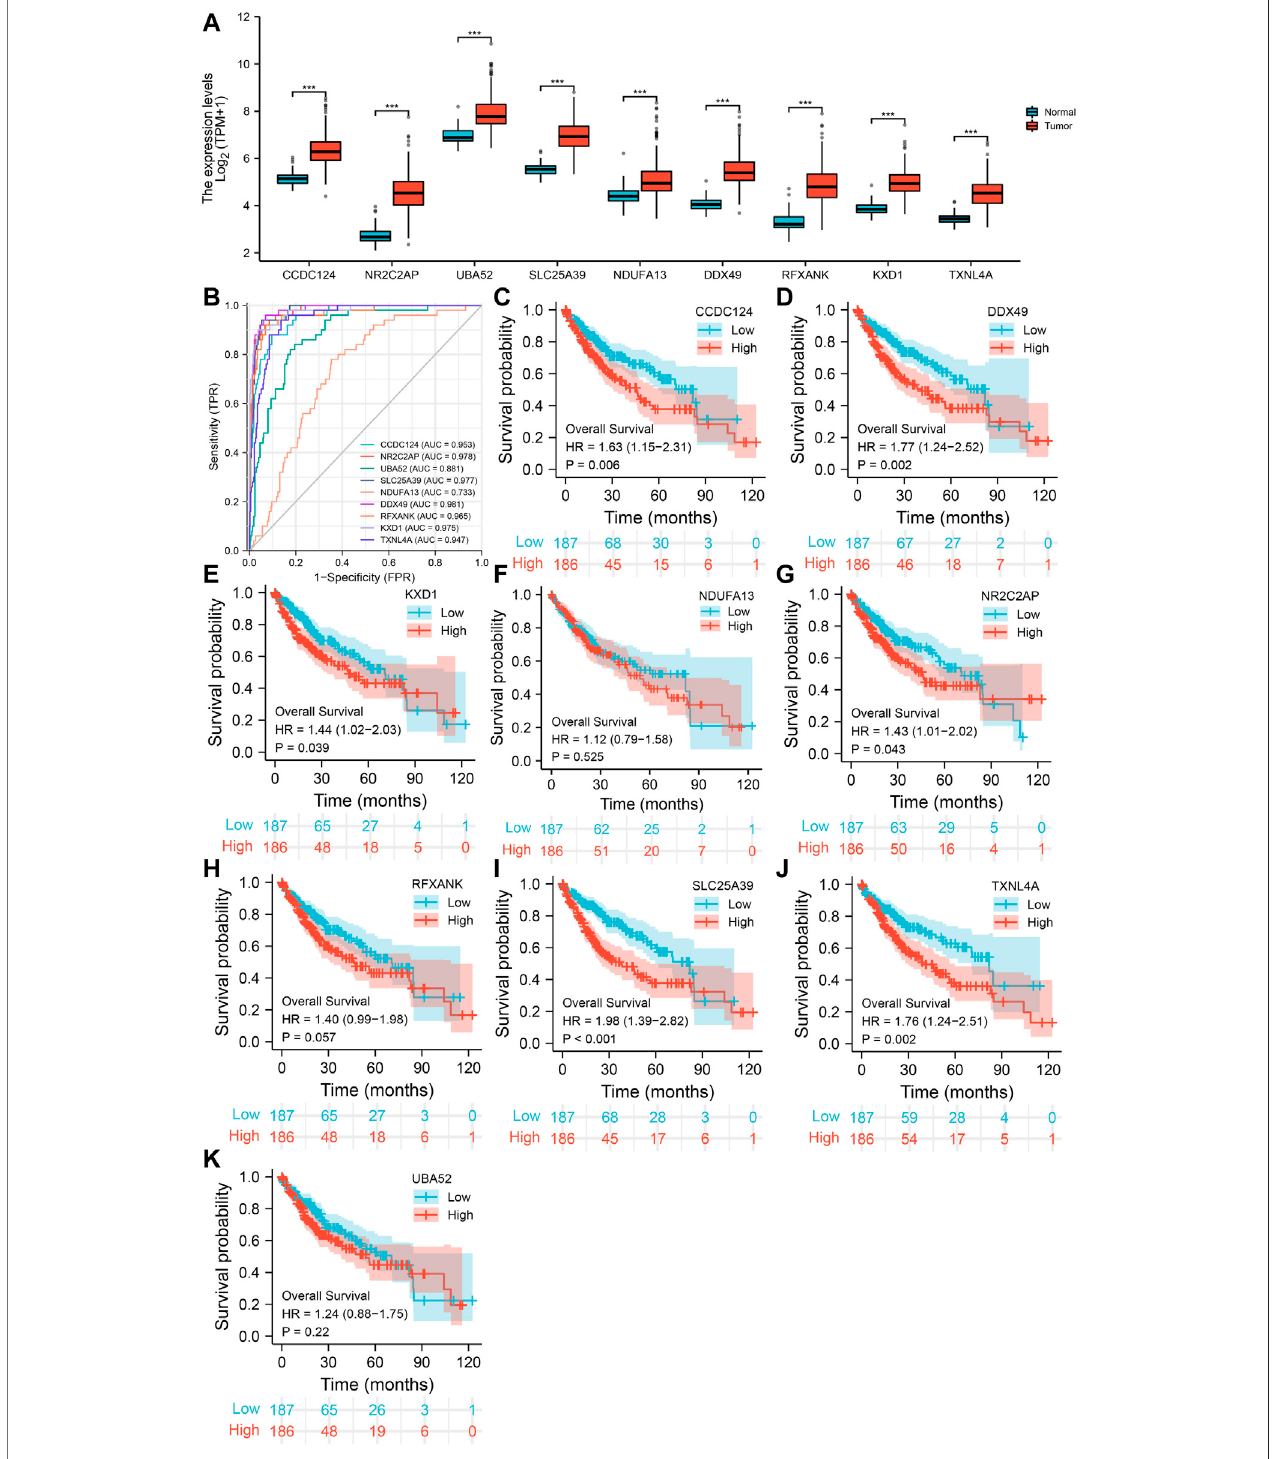
FIGURE 9 | The expression of nine co-expressed genes (CEGs) in hepatocellular carcinoma and their diagnostic and prognostic signi fi cance based on TCGA dataset. The elevated expression ofnine CEGs in HCC tissues (A) . The receiver operating characteristic (ROC) curve of LSM4 in non-HCC tissues and HCC tissues (B) . Kaplan – Meier curves of overall survival (OS) grouped by LSM4 expression in hepatocellular carcinoma (C – K) .